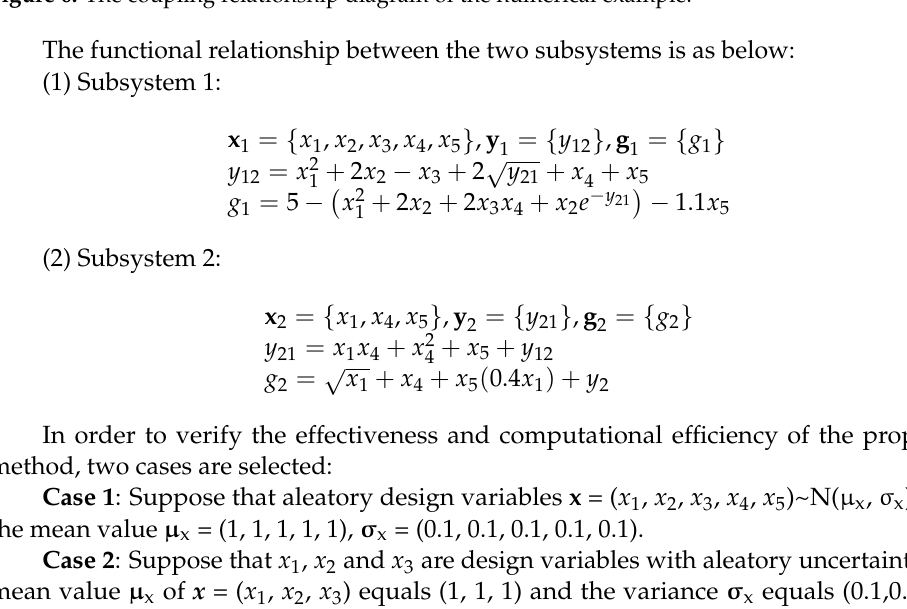
Figure 6. The coupling relationship diagram of the numerical example.